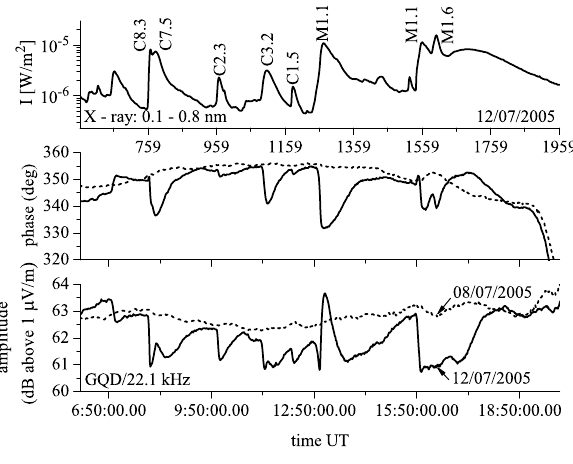
Fig. 2. Variation of X-ray irradiance and GQD signal phase and amplitude on 12 July 2005. X-ray irradiance (upper plot); phase (middle plot) and amplitude (lower plot) – solid lines. Measured phase and amplitude on quiet day (8 July 2005) – dashed